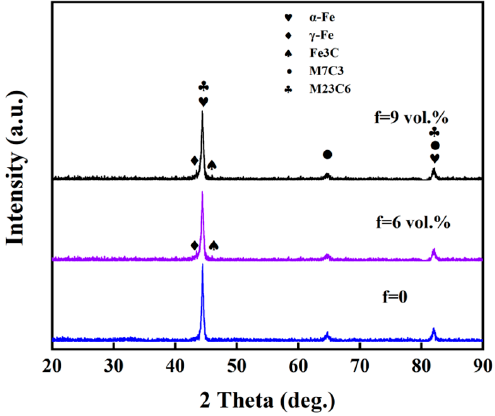
Figure 6. XRD di ff raction pa tt ern analysis of the coatings. Figure 6. XRD diffraction pattern analysis of the coatings. Figure 6. XRD diffraction pattern analysis of the coatings.